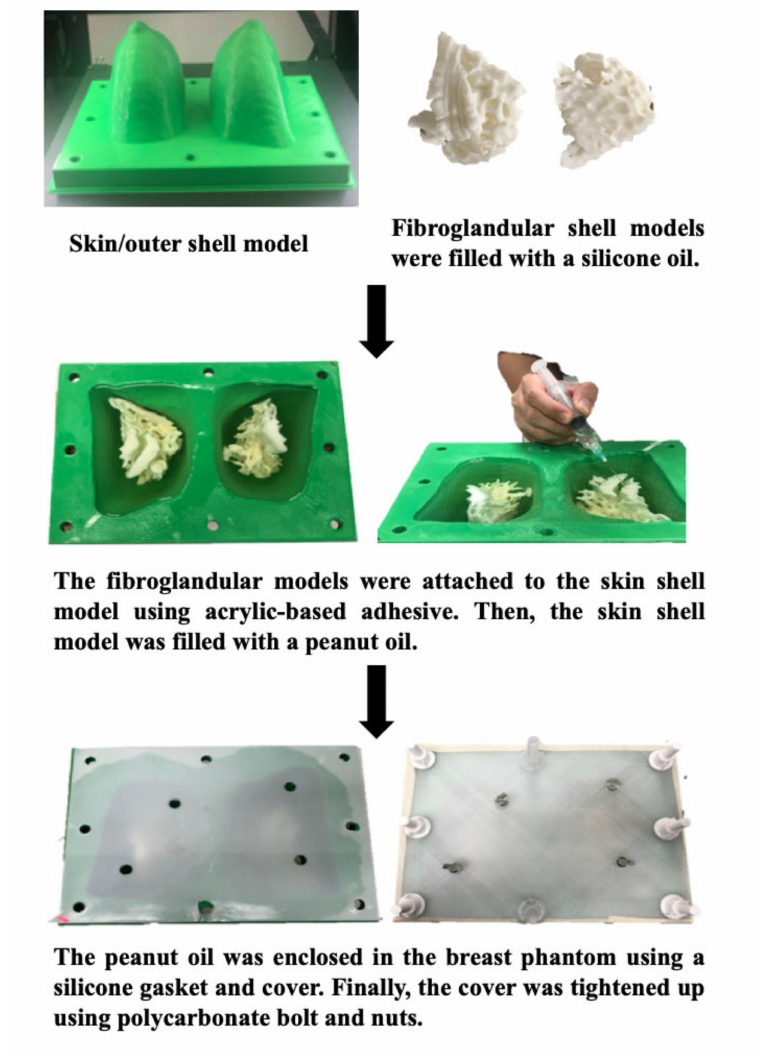
Figure 1. Flow chart demonstrates the construction process of the personalized 3D-printed breast model for MRI. Reprinted with permission under open access from Sindi et al.